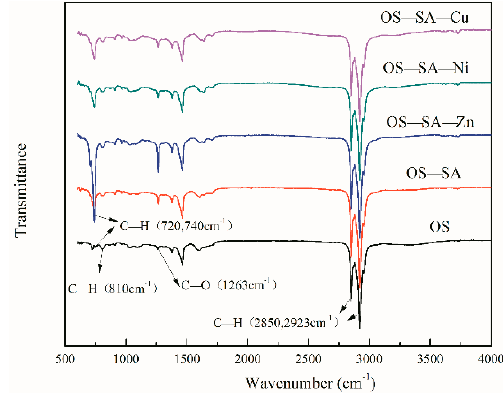
Figure 7. FTIR analysis of shale oil produced with and without catalysts.